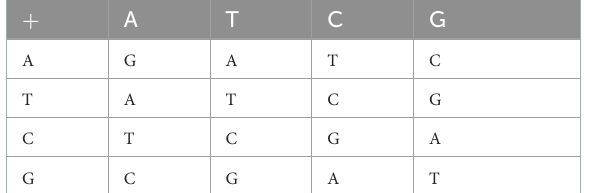
TABLE 3 DNA addition rules (corresponding to DNA encoding/decoding rule no. 4).